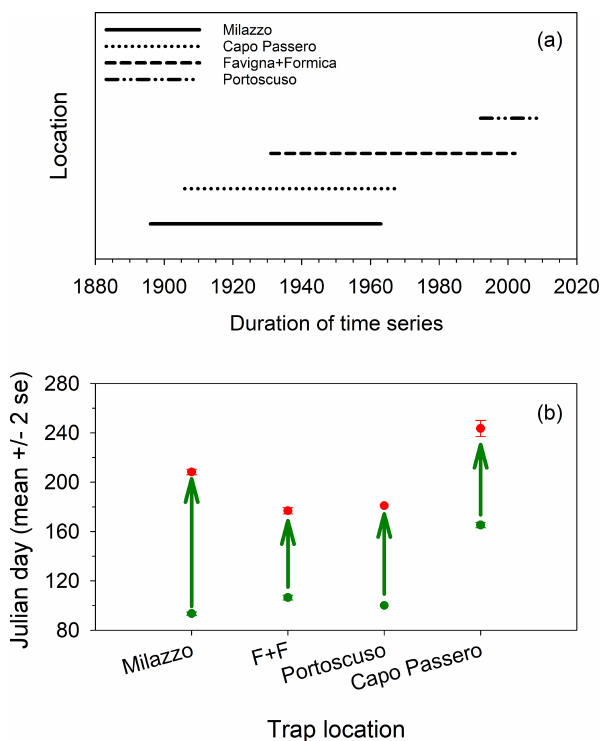
Figure 2. Summary information for temporal data availability of swordfish caught as bycatch in bluefin tuna traps in